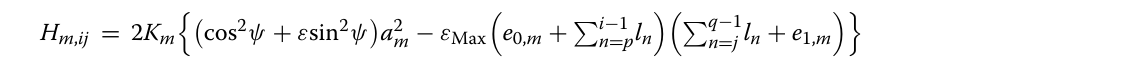
to the monoarticular and the tri-articular muscles of the McKibben artificial muscles. The stiffness of the artificial muscles, K m , was derived from the Eq. (2), considering